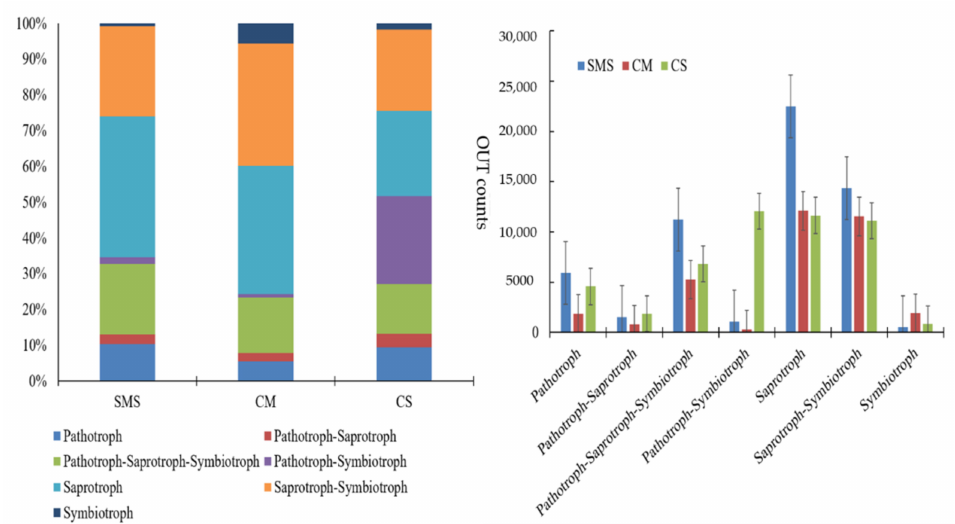
Figure 9. The relative abundance and OTUs counts for fungal functional groups (trophic modes) for each treatment based on FunGuild tool. SMS—spent mushroom substrate, CM—chicken manure, CS—control soil. Fungal communities were examined through next-generation sequencing (NGS) of the ITS1 region using Illumina MiSeq